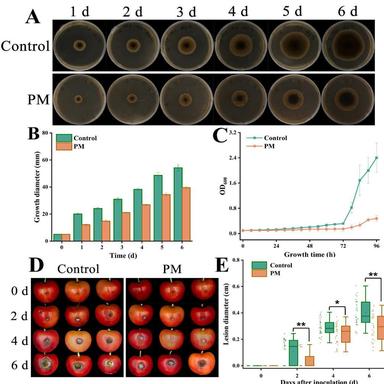
Antifungal effect of PM. Photograph of PM against Alternaria alternata (A). Growth diameter of PM against Alternaria alternata (B). Growth profiles of Alternaria alternata (C) under treatment of PM. Effect of PM on the decay of "Rainer" sweet cherries inoculated with Alternaria alternata. Images of frontal (D) and lesion diameter (E) of "Rainer" sweet cherries inoculated with Alternaria alternata. The symbol \ represent statistical differences (p < 0.05).